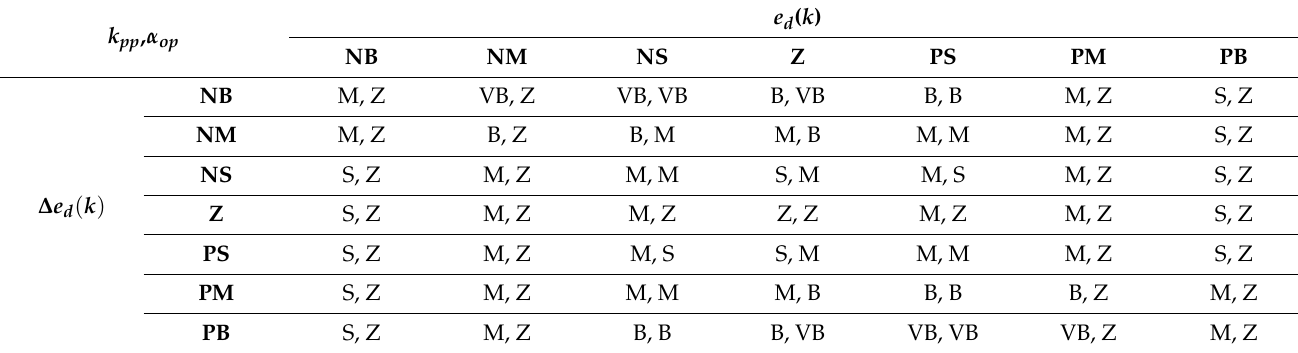
Table 2. Fuzzy rules base of chamber pressure